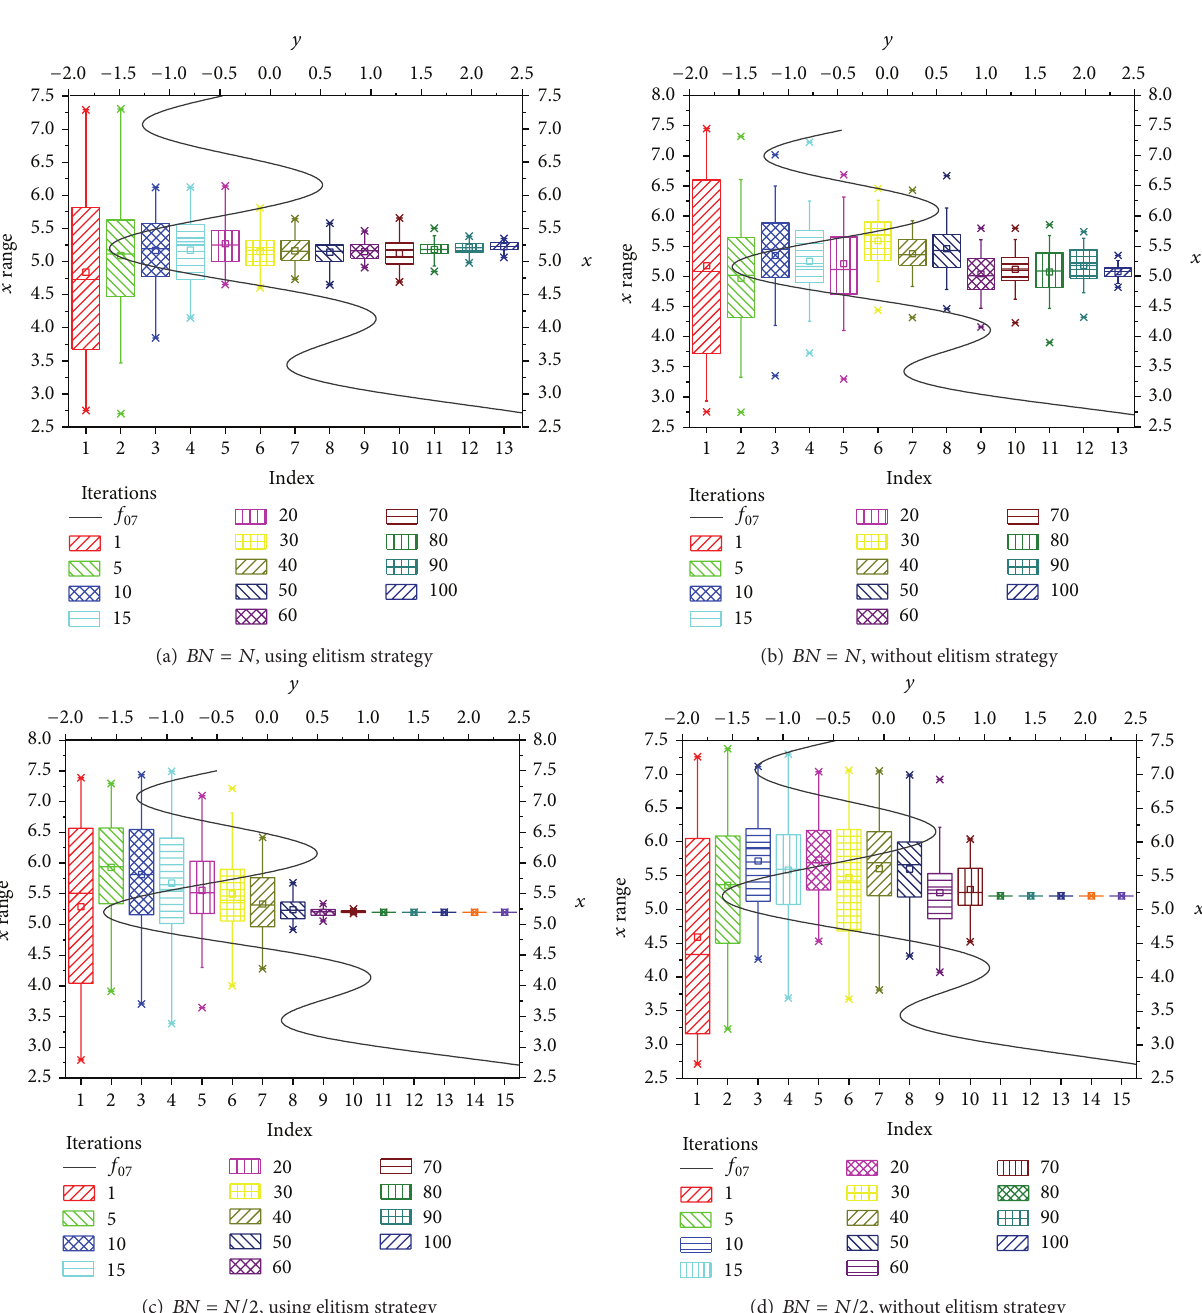
Figure 6: The boxplot of population for different